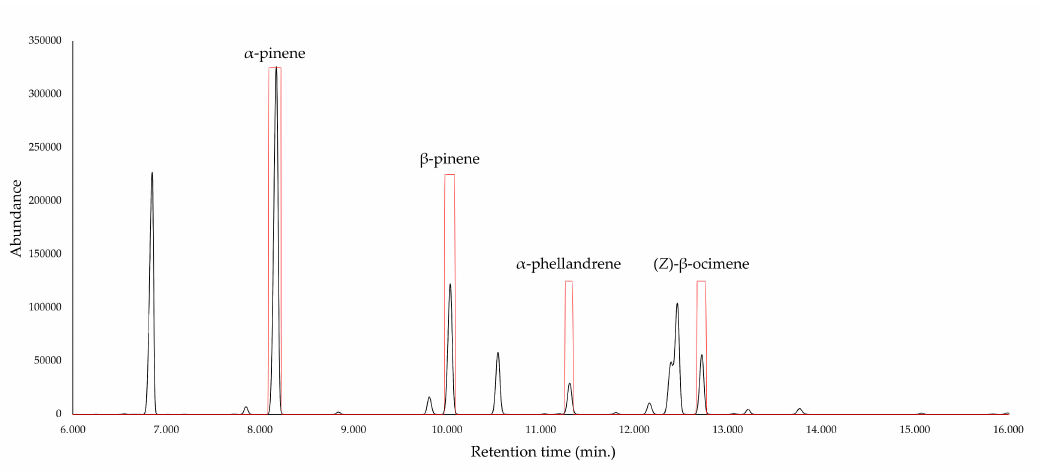
Figure 2. AEDA aromagram of D. mutisii EO with DB-5ms